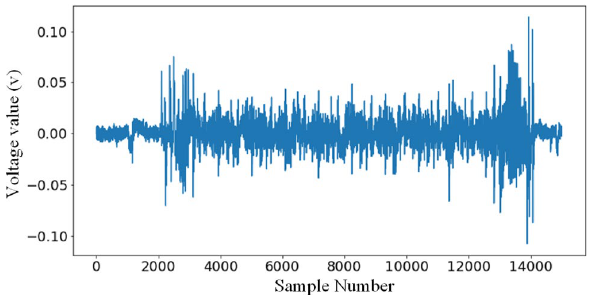
Figure 8. Waveform of the last round traces of the NVIDIA GeForce GT620 graphics card implementation of TintAES-128 (AES_GPU).